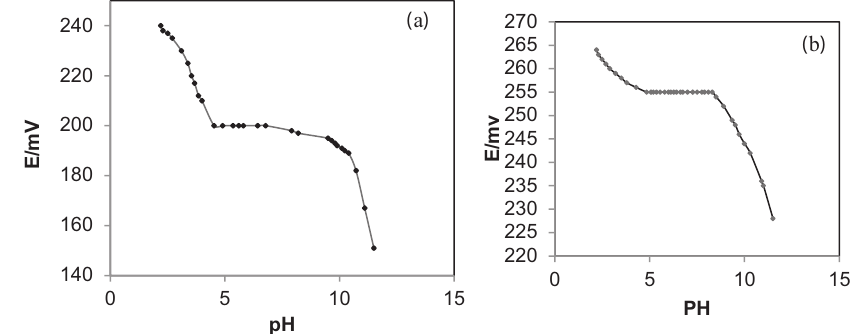
Figure 3: pH-potential profile of the BIS sensor for (a) 1.0×10 -2 mol L -1 BIS and (b) 1.0×10 -3 mol L -1 BIS.